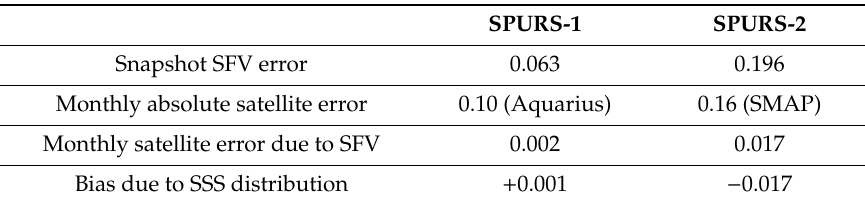
Table 2. Summary of error values quoted in the